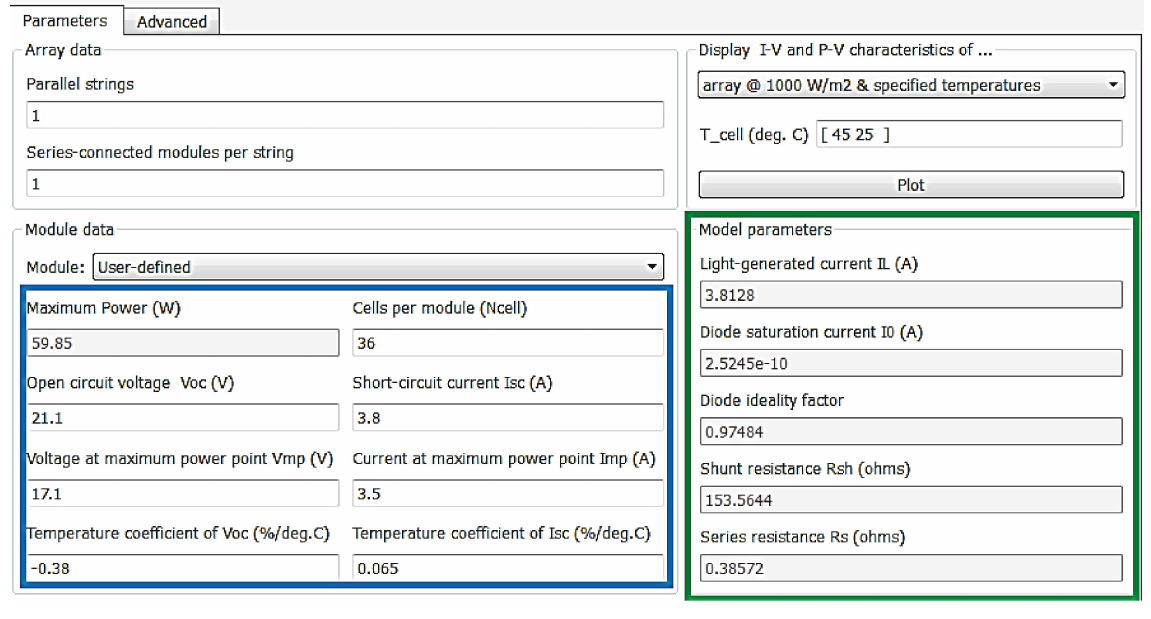
Figure 2: PV array